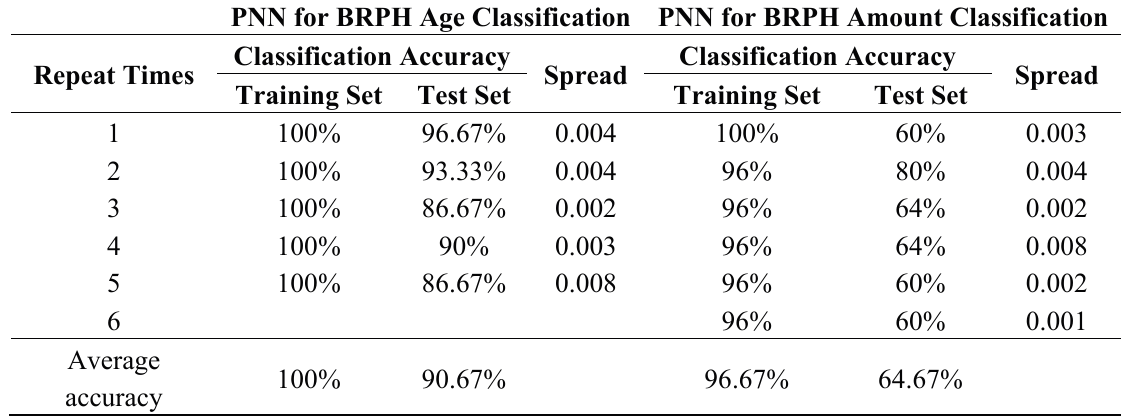
Table 4. PNN for BRPH age and amount classification based on K-fold